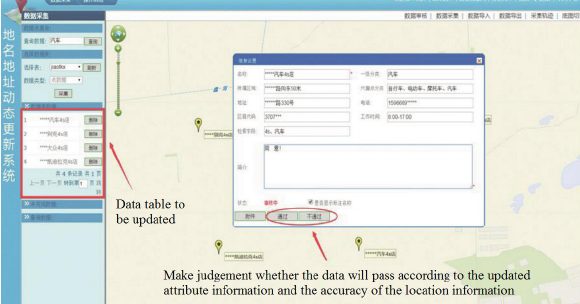
Figure 4. Mobile collection terminal